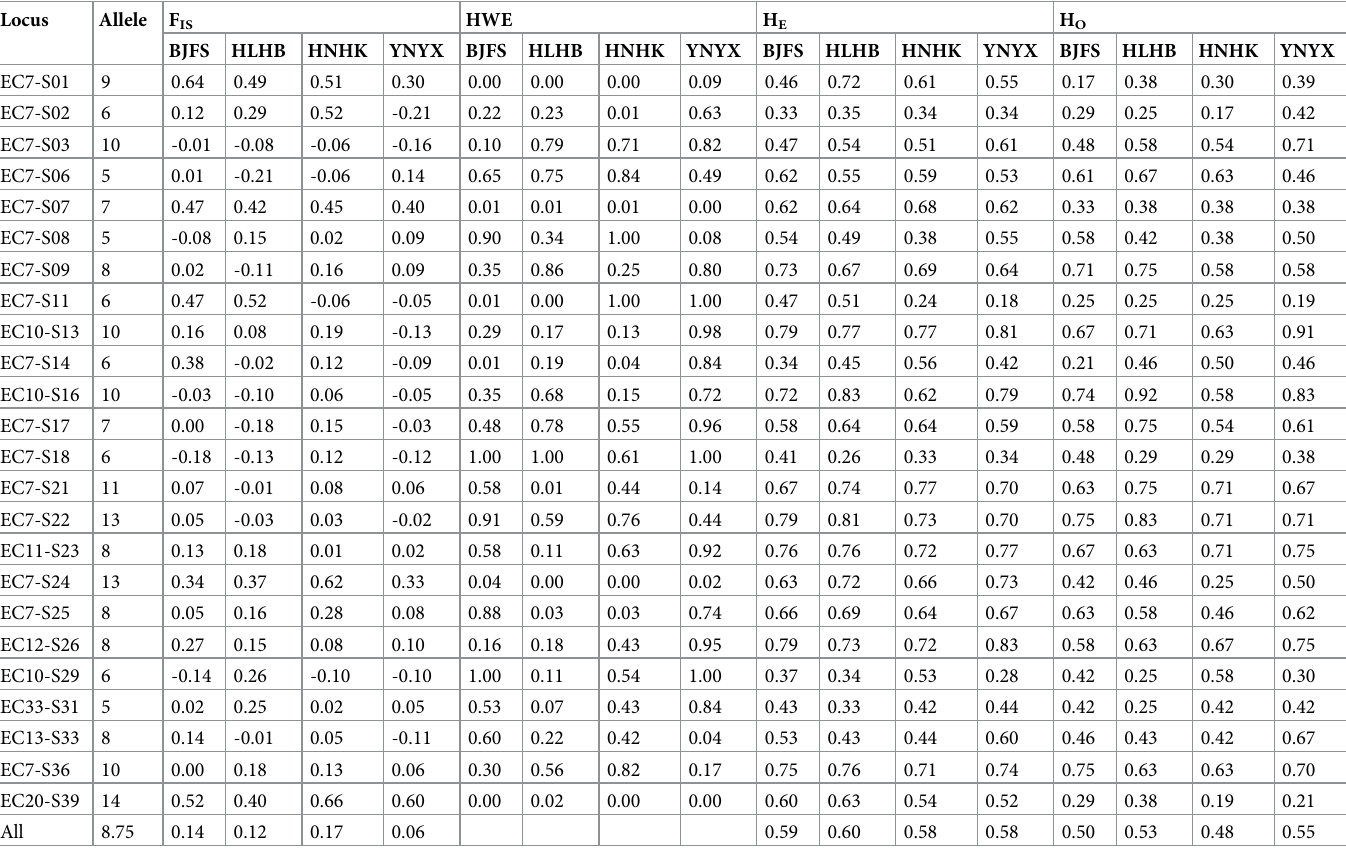
Table 3. Summary statistics of 24 microsatellite markers for Eupeodes corollae validated in four populations. F IS , inbreeding coefficient; He, expected heterozygosity; Ho, observed heterozygosity; HWE, average P-value of Hardy–Weinberg equilibrium. Locus Allele F IS HWE